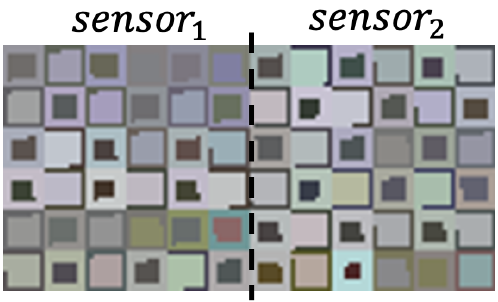
Figure 10. Augmented canvas for multiple